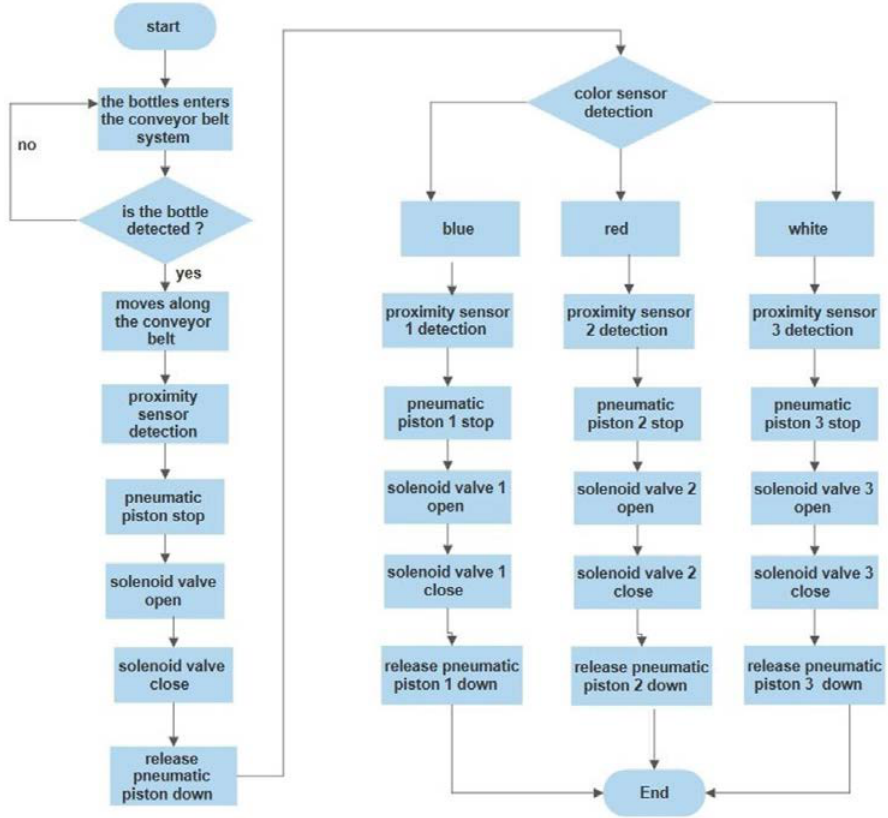
Figure 6. Flow chart of customized yogurt filling system. Figure 5. Flow chart of customized yogurt filling